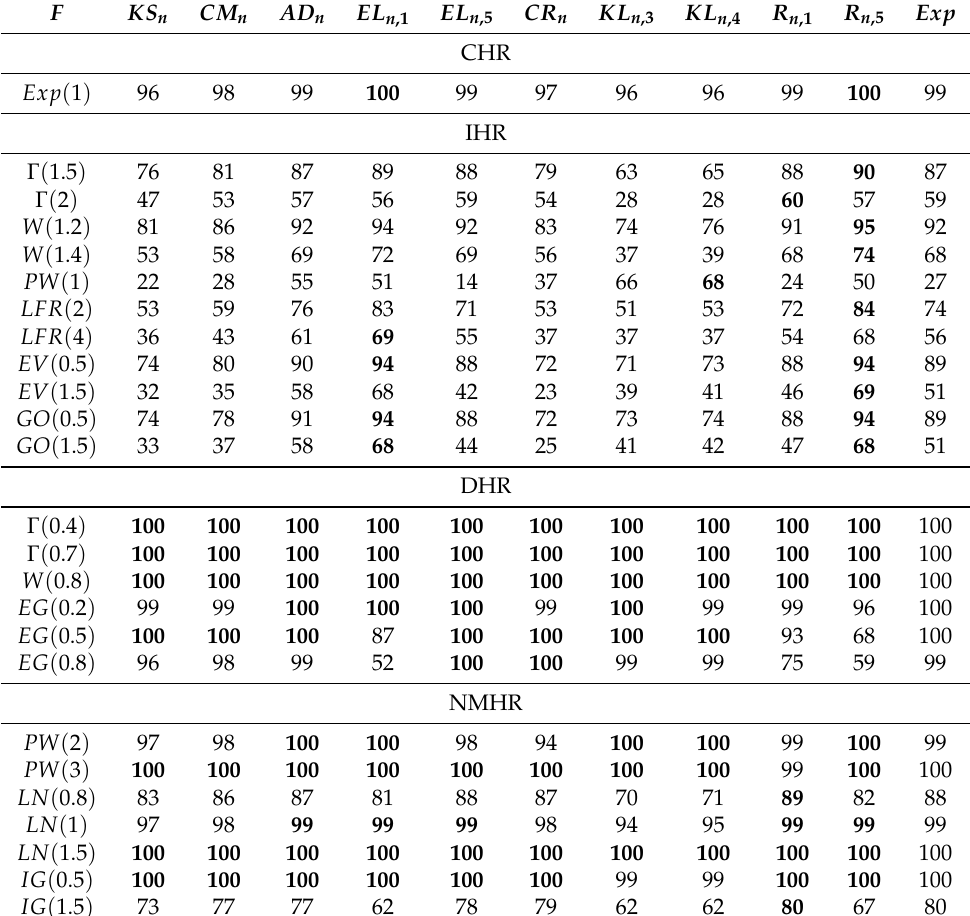
Table 5. Estimated powers for general alternatives for the Rayleigh distribution for sample size n = 30.